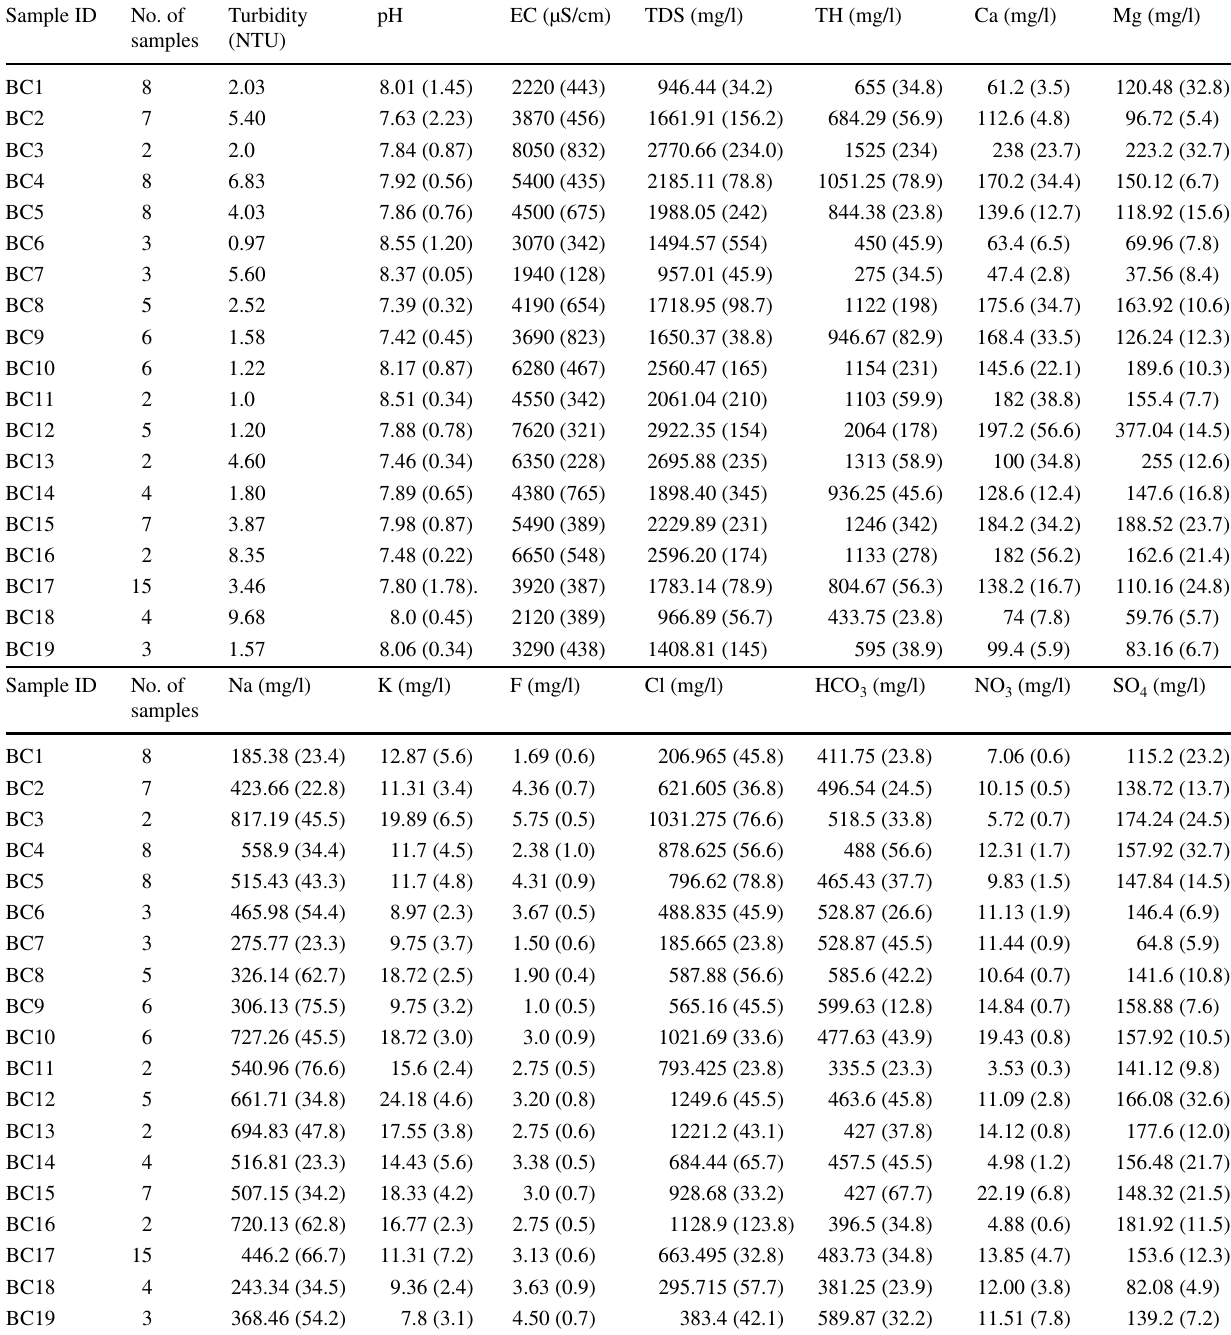
Table 2 Analytical results (mean values) of groundwater samples in Bhakra Canal catchment area (site 2) Sample